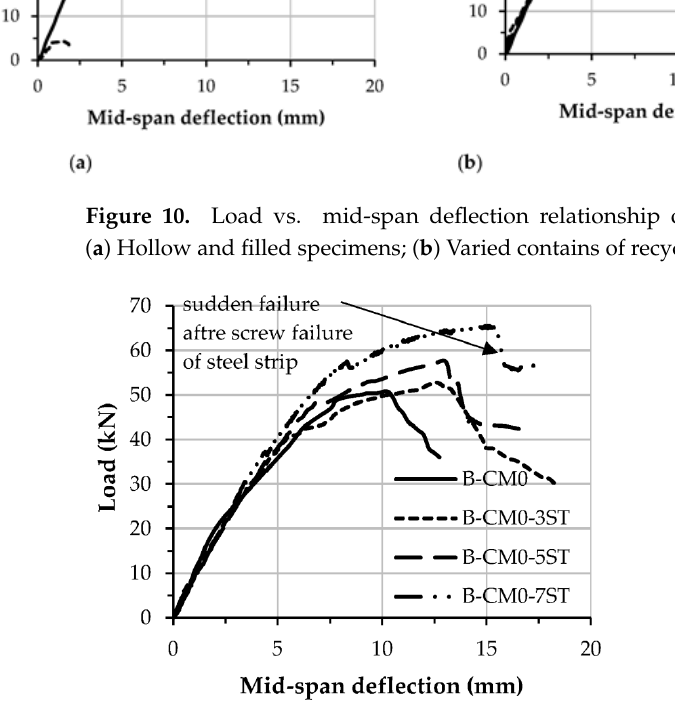
Figure 11. Load vs. mid-span deflection relationship of stiffened specimens with steel strips.